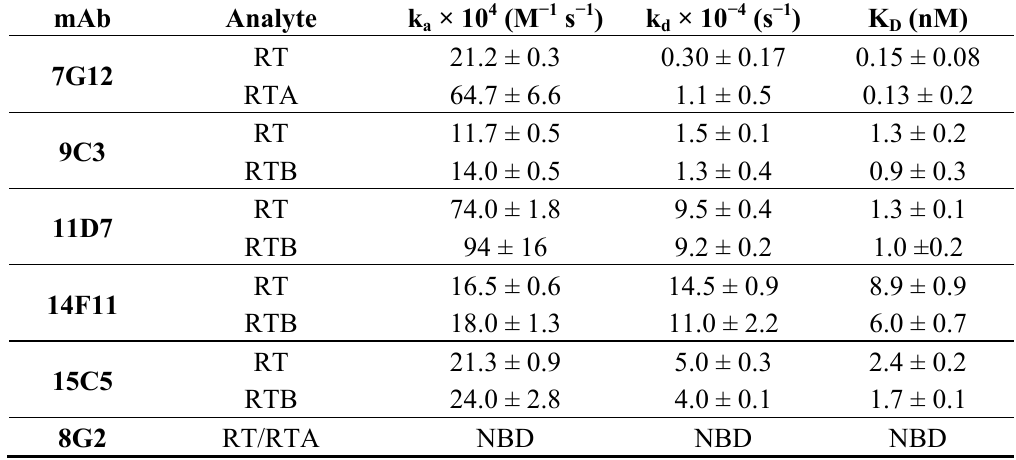
Table 1. Association and dissociation rate and equilibrium dissociation constants of mAbs interacting with ricin (RT: n = 3), subunit A (RTA: n = 2) and subunit B (RTB: n = 2). mAb